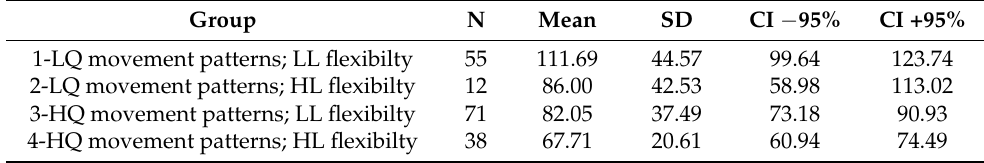
Table 3. Descriptive statistics of the ranks injuries aligned before ranks calculation.